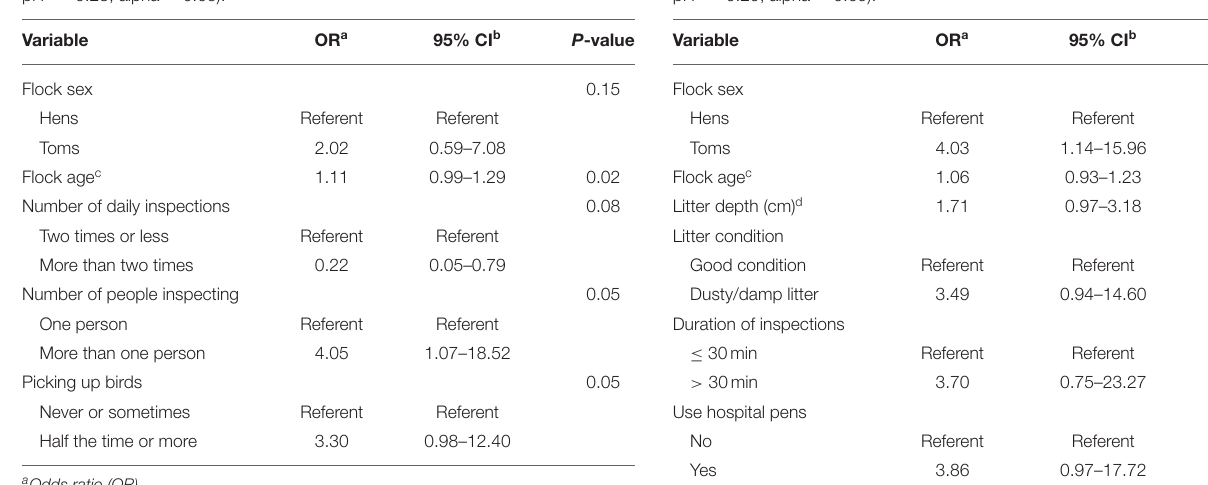
TABLE 5 | Final logistic regression model for the presence of BT injuries ( N = 59, pR 2 = 0.29, alpha =